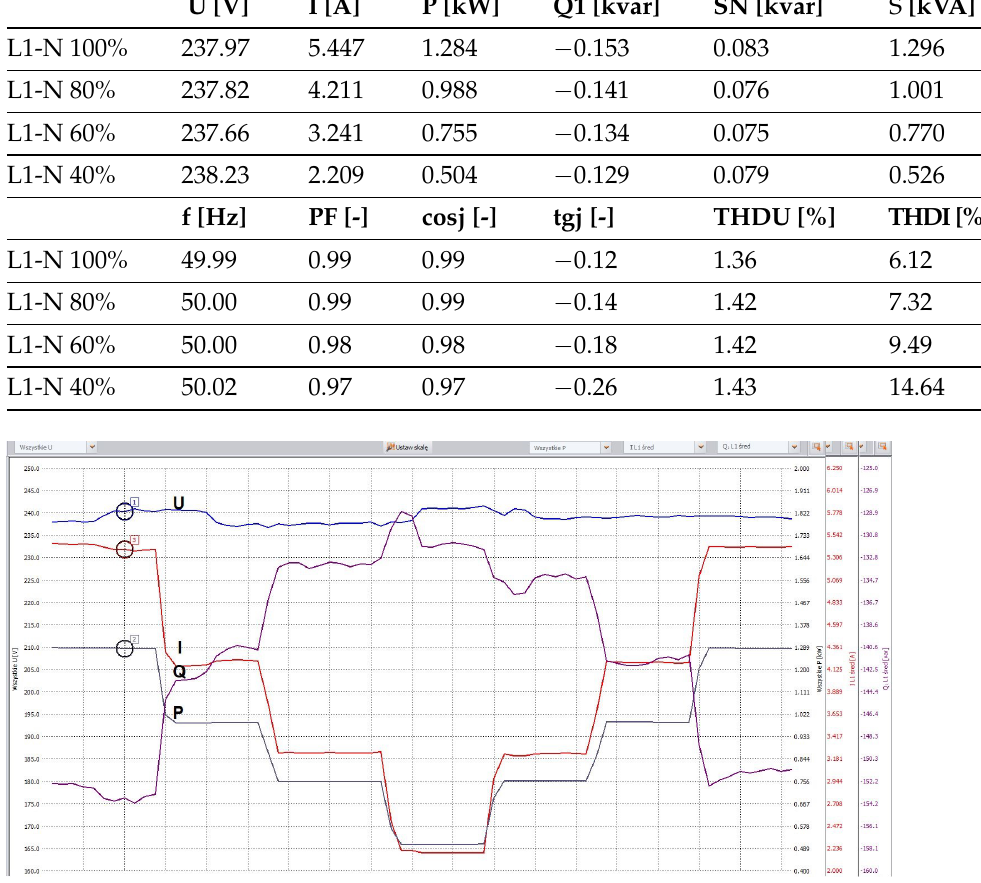
Figure 4. Characteristic changes in the value of voltage, current, active power and reactive power in circuit 1 of the tested lighting installation—LED source.